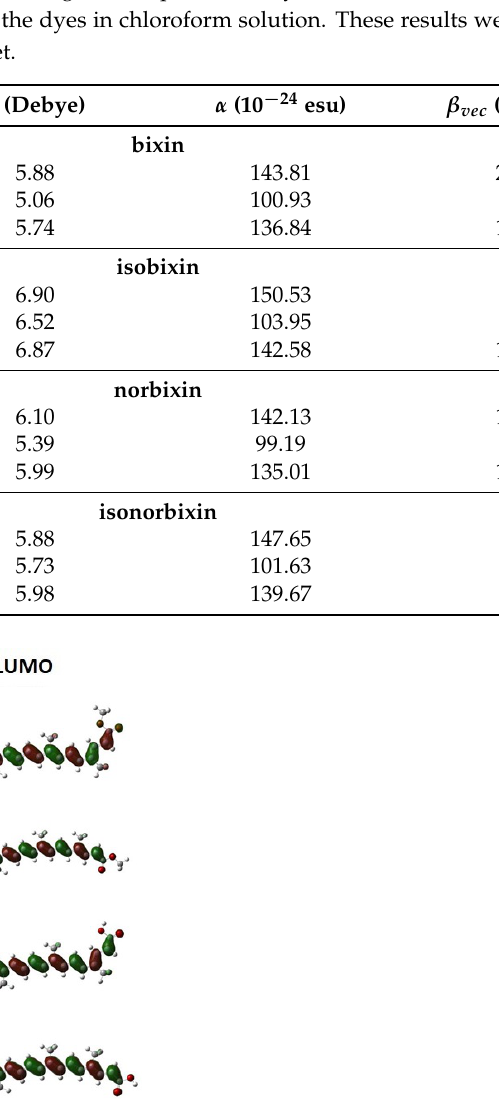
Figure A2. Schematic representation of the frontier molecular orbitals HOMO (left) and LUMO (right) of the molecular dyes in chloroform solution. These results were obtained by employing the M06/6-31+G(d,p) level of